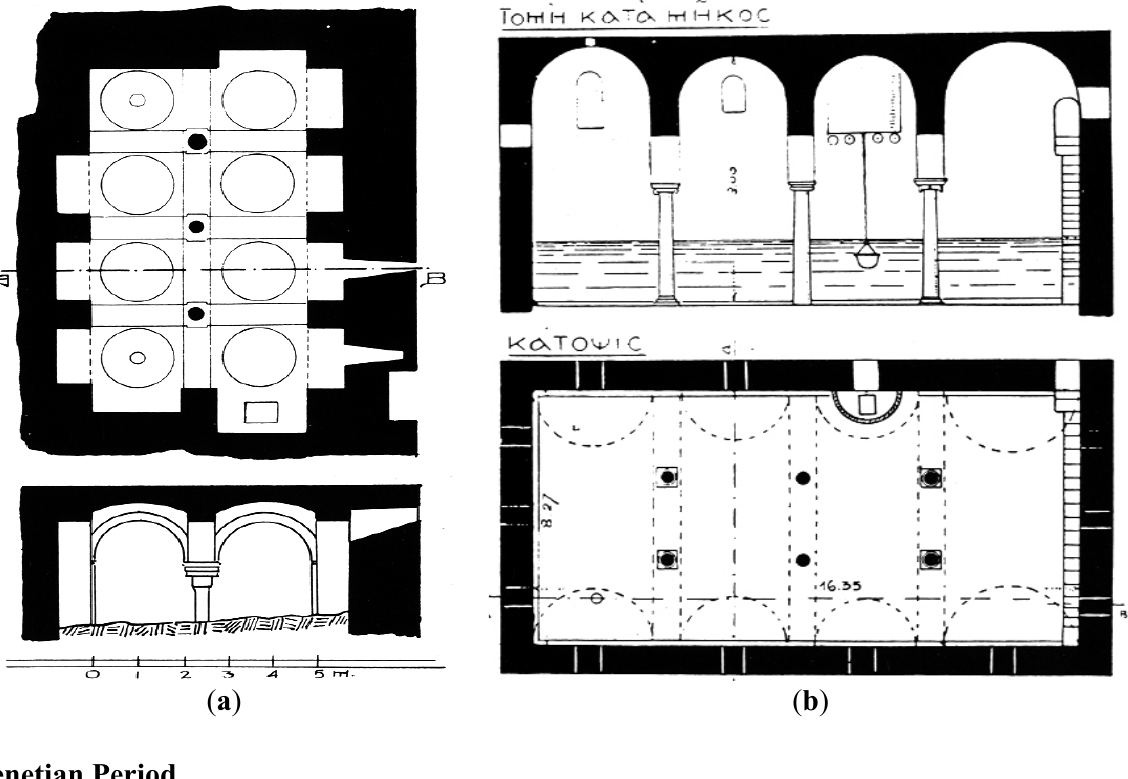
Figure 16. Cisterns at monasteries: ( a ) cistern at Osios Loukas monastery in Boeotia, Greece [31] covered with lowered domes and ( b ) cistern at Ag. Apostoles monastery in Thessaloniki, Greece [31] covered with simple